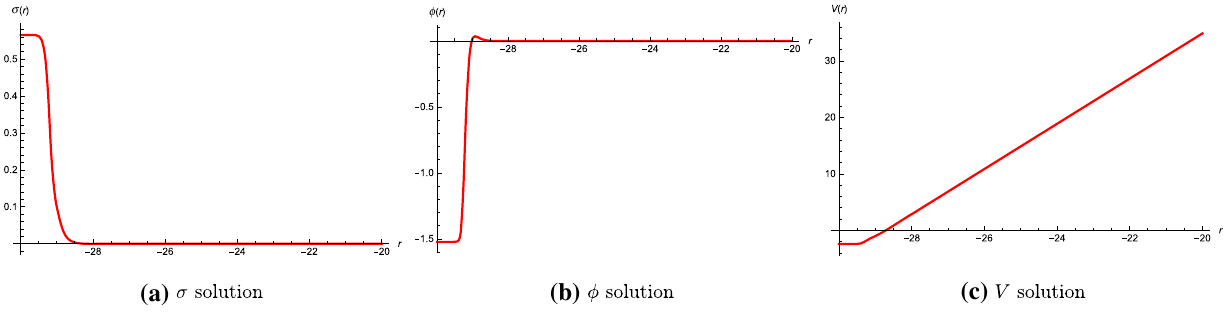
Fig. 17 An RG flow from SO ( 4 ) N = ( 1 , 0 ) SCFT in six dimensions to two-dimensional N = ( 1 , 0 ) SCFT with SO ( 3 ) diag symmetry dual to